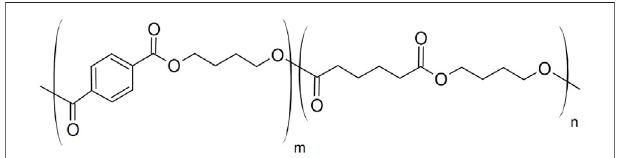
FIGURE 4 | Chemical structure of polybutylene adipate terephthalate.